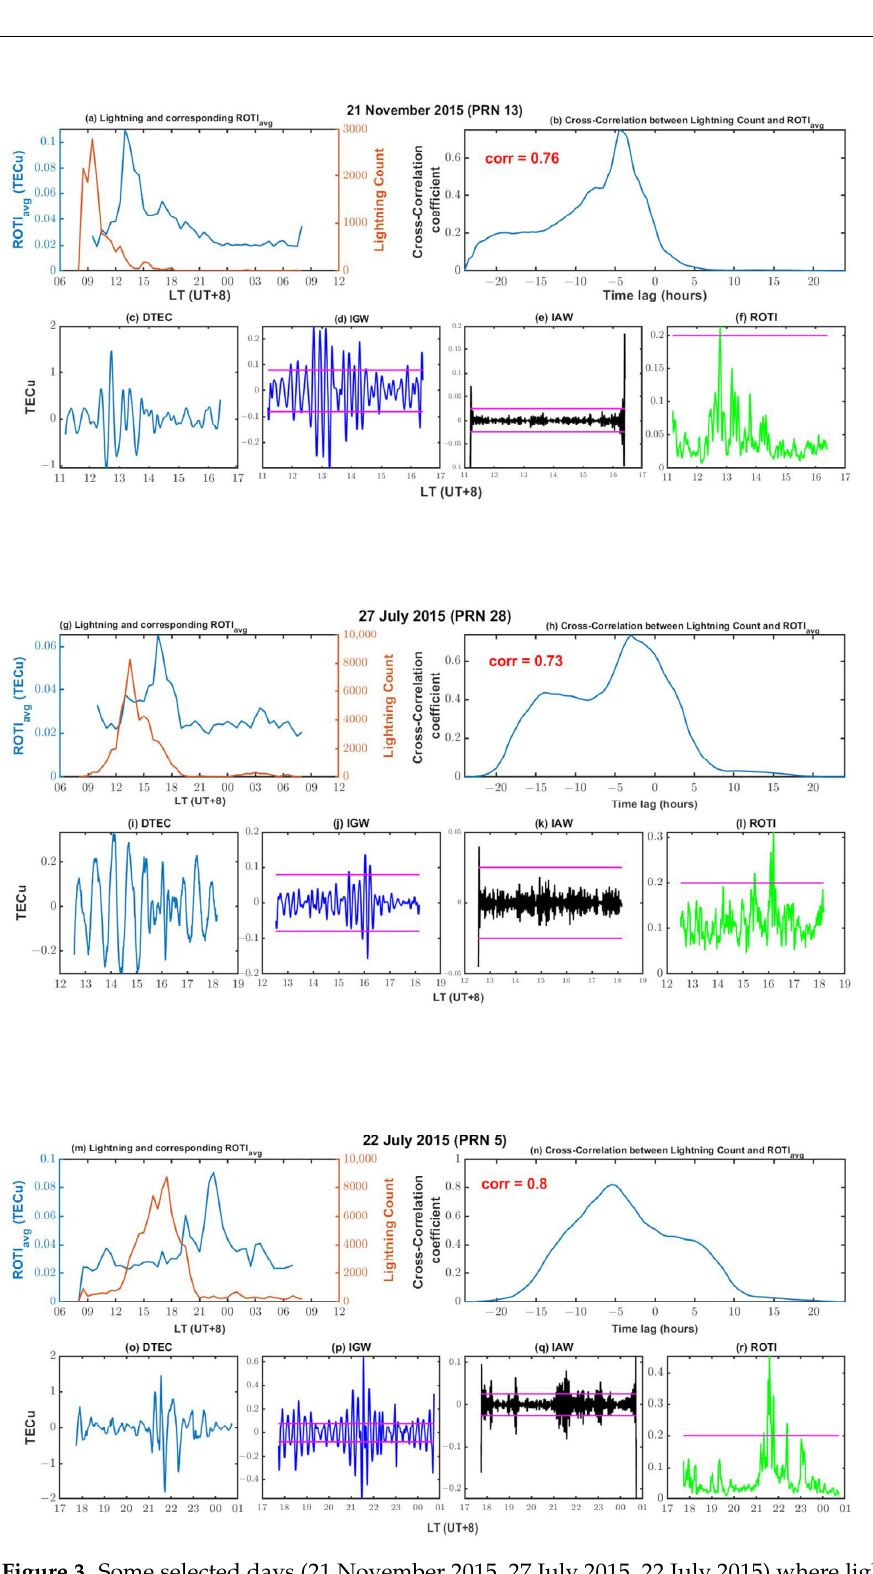
Figure 3. Some selected days (21 November 2015, 27 July 2015, 22 July 2015) where lightning was predominantly in the daytime (07–17 local time) and its cross-correlation with ROTI avg ( top rows of each day ). The associated ionospheric disturbances are also indicated by DTEC, IGW, IAW, and ROTI ( bottom rows of each day ) by satellites that passed some hours after the lightning activity. The magenta lines show the threshold of ±0.08 TECu, ±0.025 TECu and 0.2 TECu for IGW, IAW and ROTI respectively.